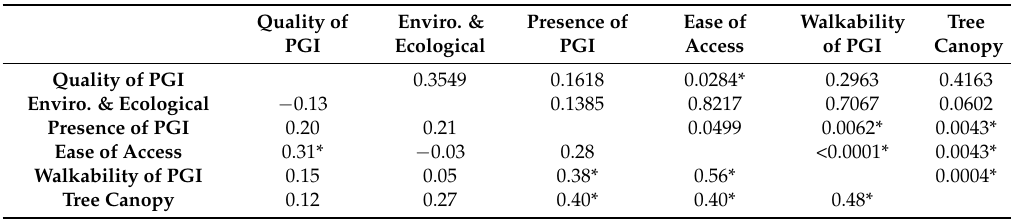
Table 5. Correlations (lower left) between reporting of PGI attributes that contribute to urban livability and the p-values for significance of the correlations (upper right). Significant correlations and the associated p-value are indicated by an *.